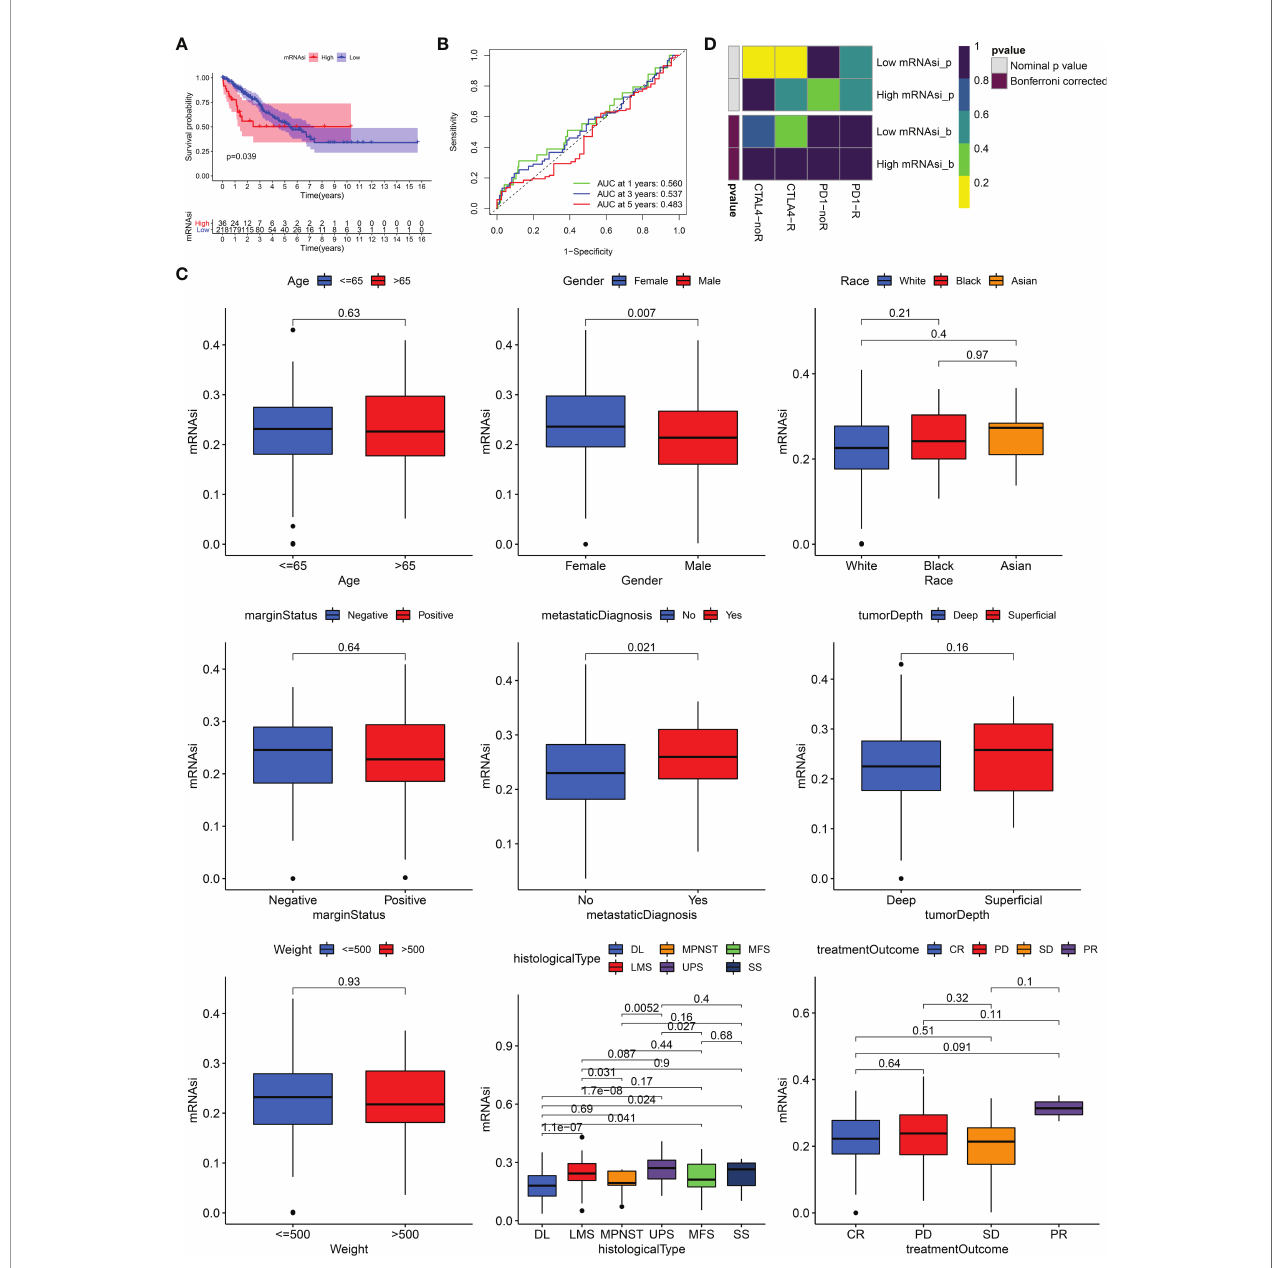
FIGURE 1 | The role of mRNAsi in STS. (A) K – M survival analysis of patients with high and low mRNAsi. (B) The receiver operating characteristic (ROC) curve of mRNAsi in predicting survival of STS. (C) The differences of mRNAsi in patients with different characteristics. DL, dedifferentiated liposarcoma; MPNST, malignant peripheral nerve sheath tumors; MFS, myxo fi brosarcoma; LMS, leiomyosarcoma; UPS, undifferentiated pleomorphic sarcoma; SS, synovial sarcoma; CR, complete response; PD, progressive disease; SD, stable disease; PR, partial response. (D) The response of patients with high and low mRNAsi to PD1 and CTLA4 inhibitors (Benjamini and Hochberg corrected p >